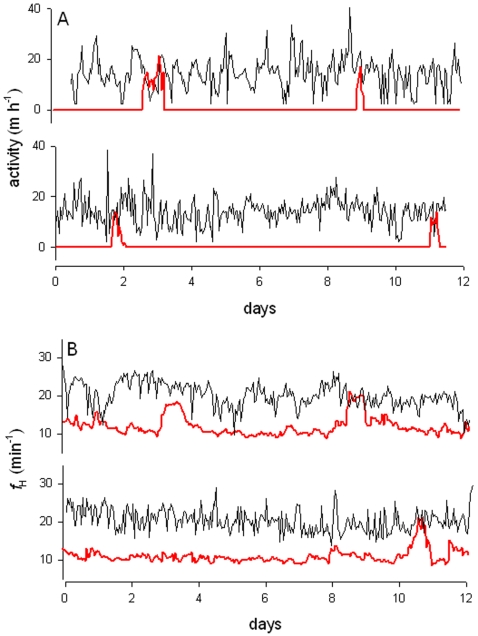
Summer and winter comparison of hourly activity and f
H profiles in N. coriiceps.
Panel A shows activity profiles from two separate fish remotely recorded by acoustic telemetry during summer months (black), and the activity profile for the same fish is also shown during winter months (red). The flat line indicates when the fish were sedentary. Panel B shows the mean hourly f
H from two sea-caged N. coriiceps during summer (black) and f
H for the same fish during winter (red).